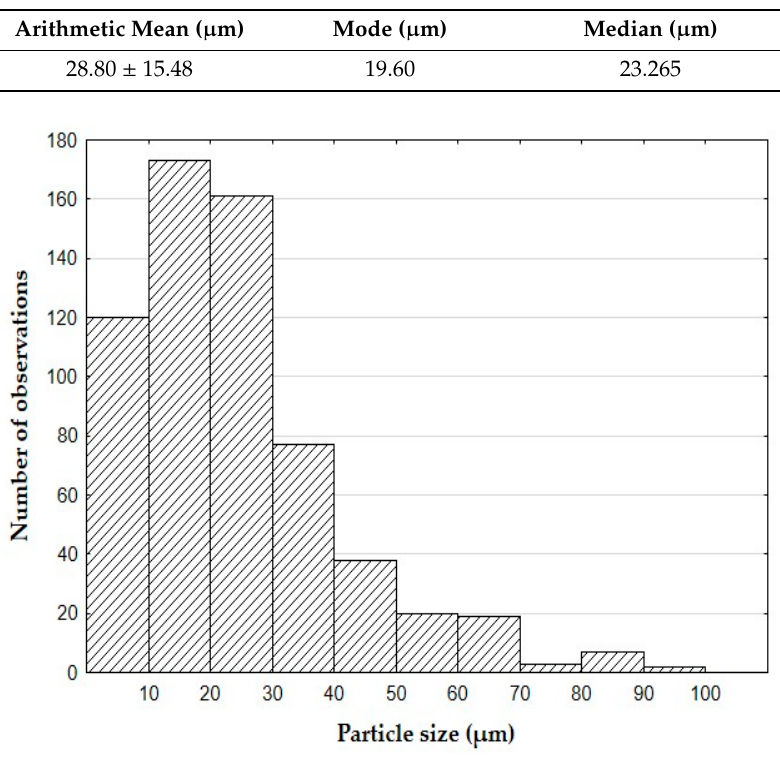
Figure 1. The histogram of particle size frequency of eggshell filler.